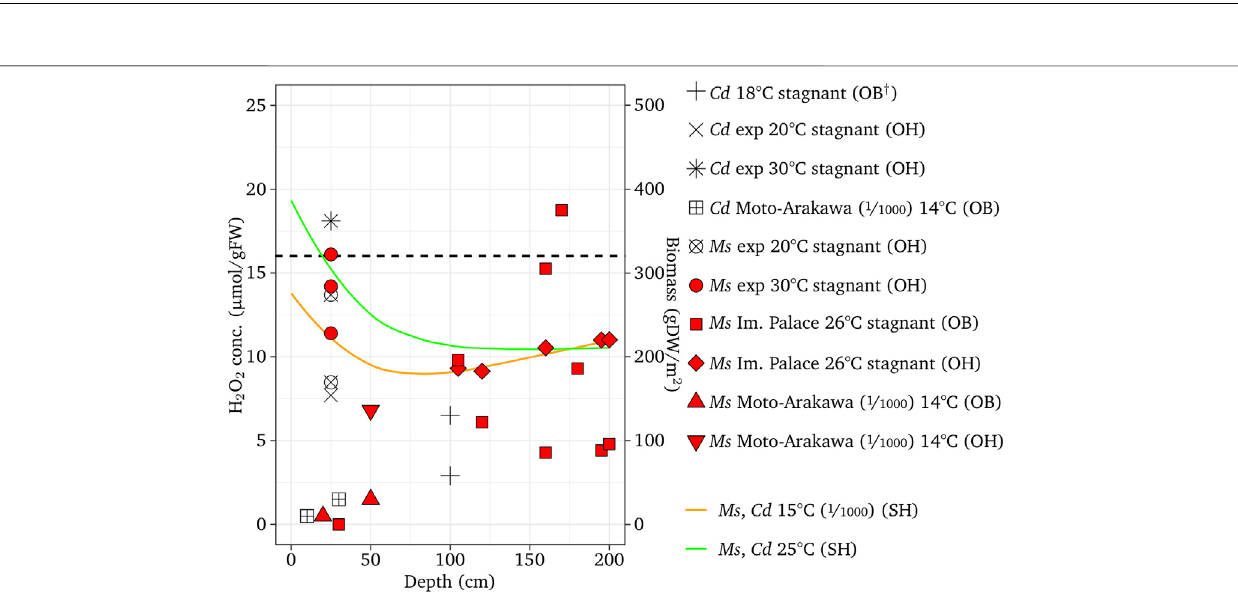
FIGURE 7 | Simulated H 2 O 2 concentrations with different temperatures compared with the observed results for M. spicatum (Ms in the legend) and C. demersum (Cd in the legend) compared with observed data. † Represents Fukuhara et al. (1997); ‘ OB ’ , ‘ SH ’ and ‘ SH ’ designate observed biomass, observed H 2 O 2 and simulated H 2 O 2 , respectively. The fractions in the parentheses are channel